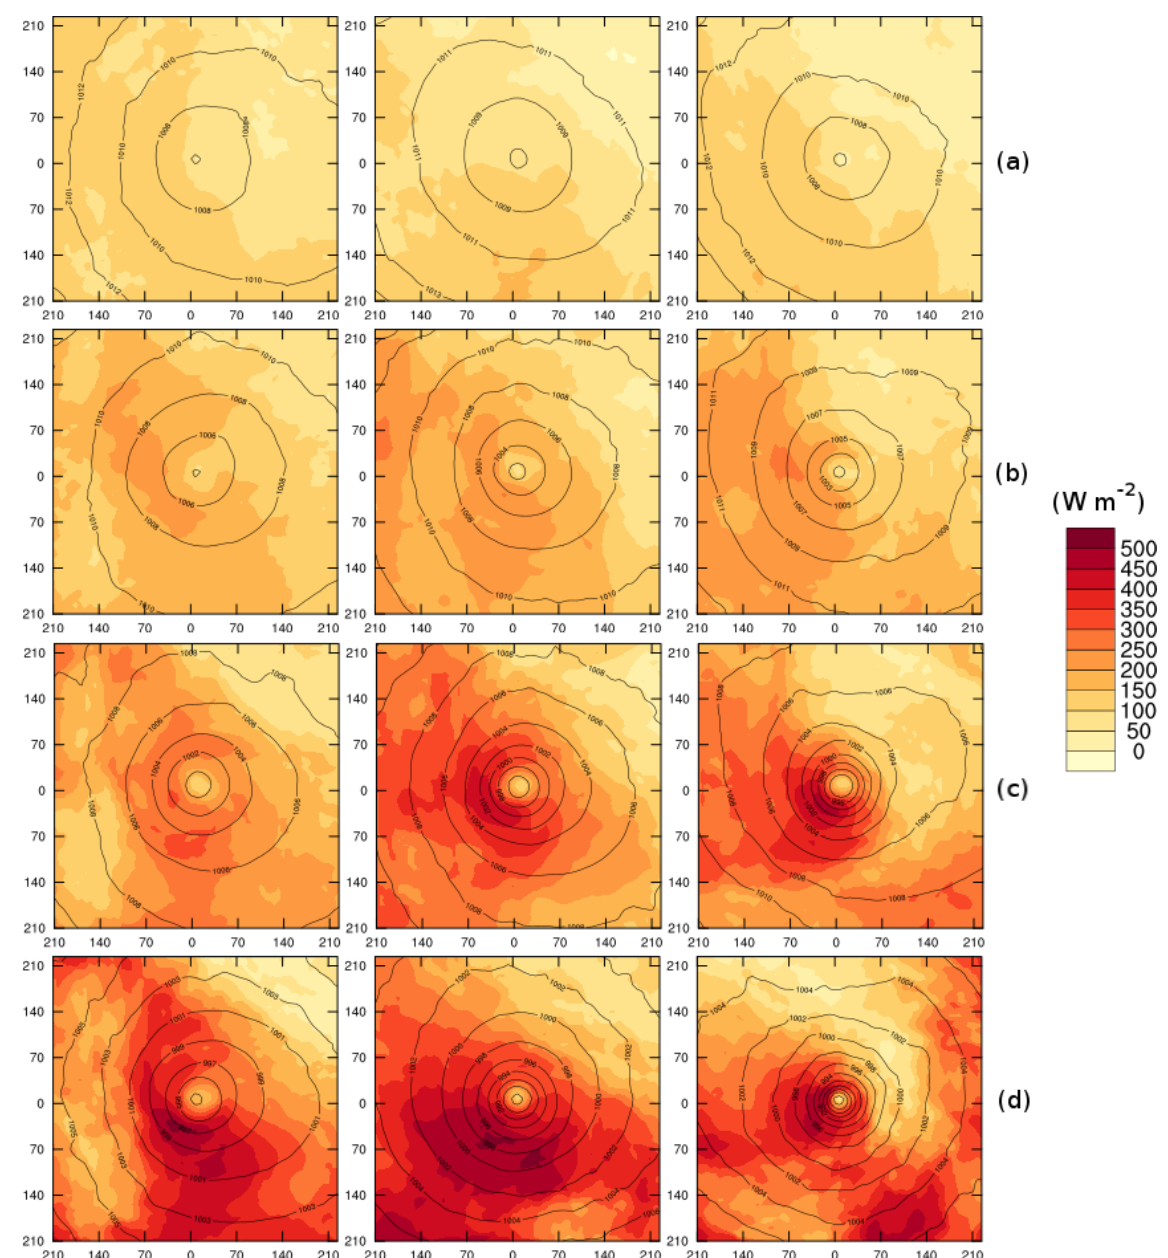
Figure 11. Composite latent heat fluxes from the sea for an SST change of (a) − 3K, (b) 0K (original SSTs), (c) + 3K and (d) + 6K (colors), as well as composite mean sea level pressure (contours) at MWCT − 20h (left column), MWCT − 10h (center column) and MWCT (right column). The values on the x and y axis indicate the distance from the center of the medicane in